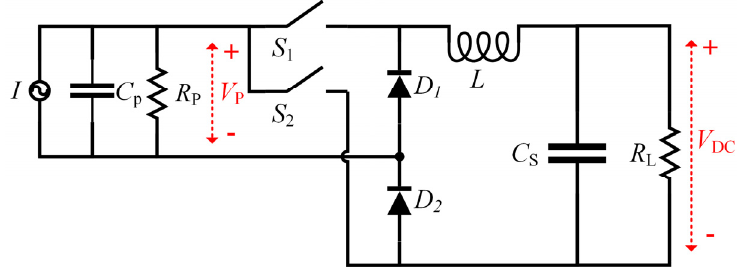
Figure 7. The SECE based on the Buck structure.